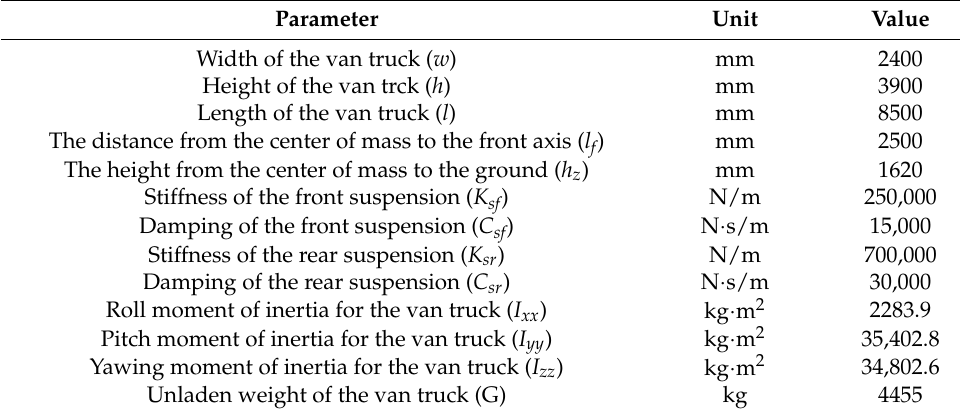
Table 1. Main parameters of the vehicle dynamics for the van truck.